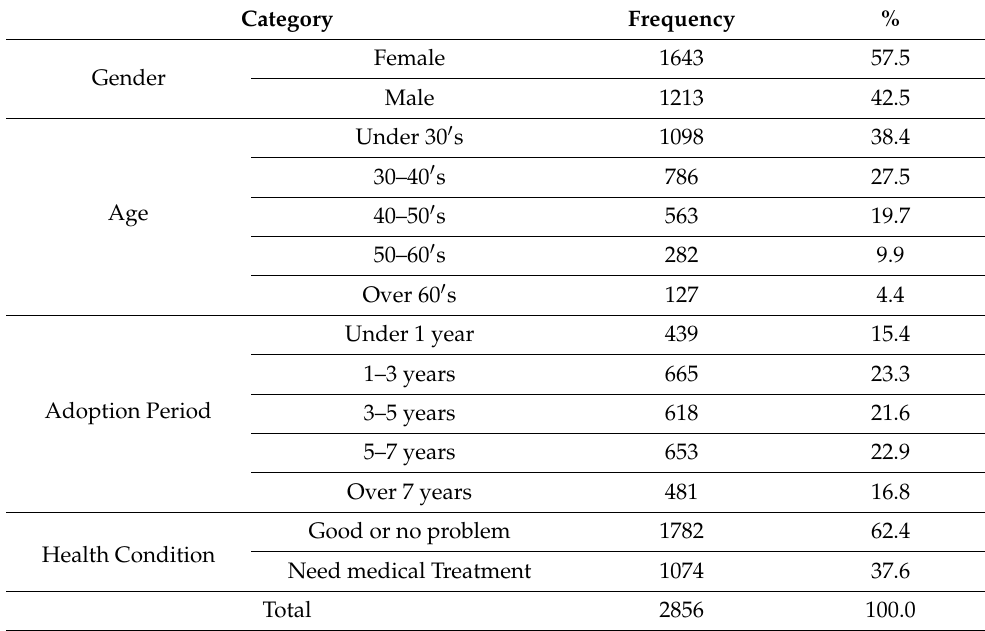
Table 4. Descriptive data